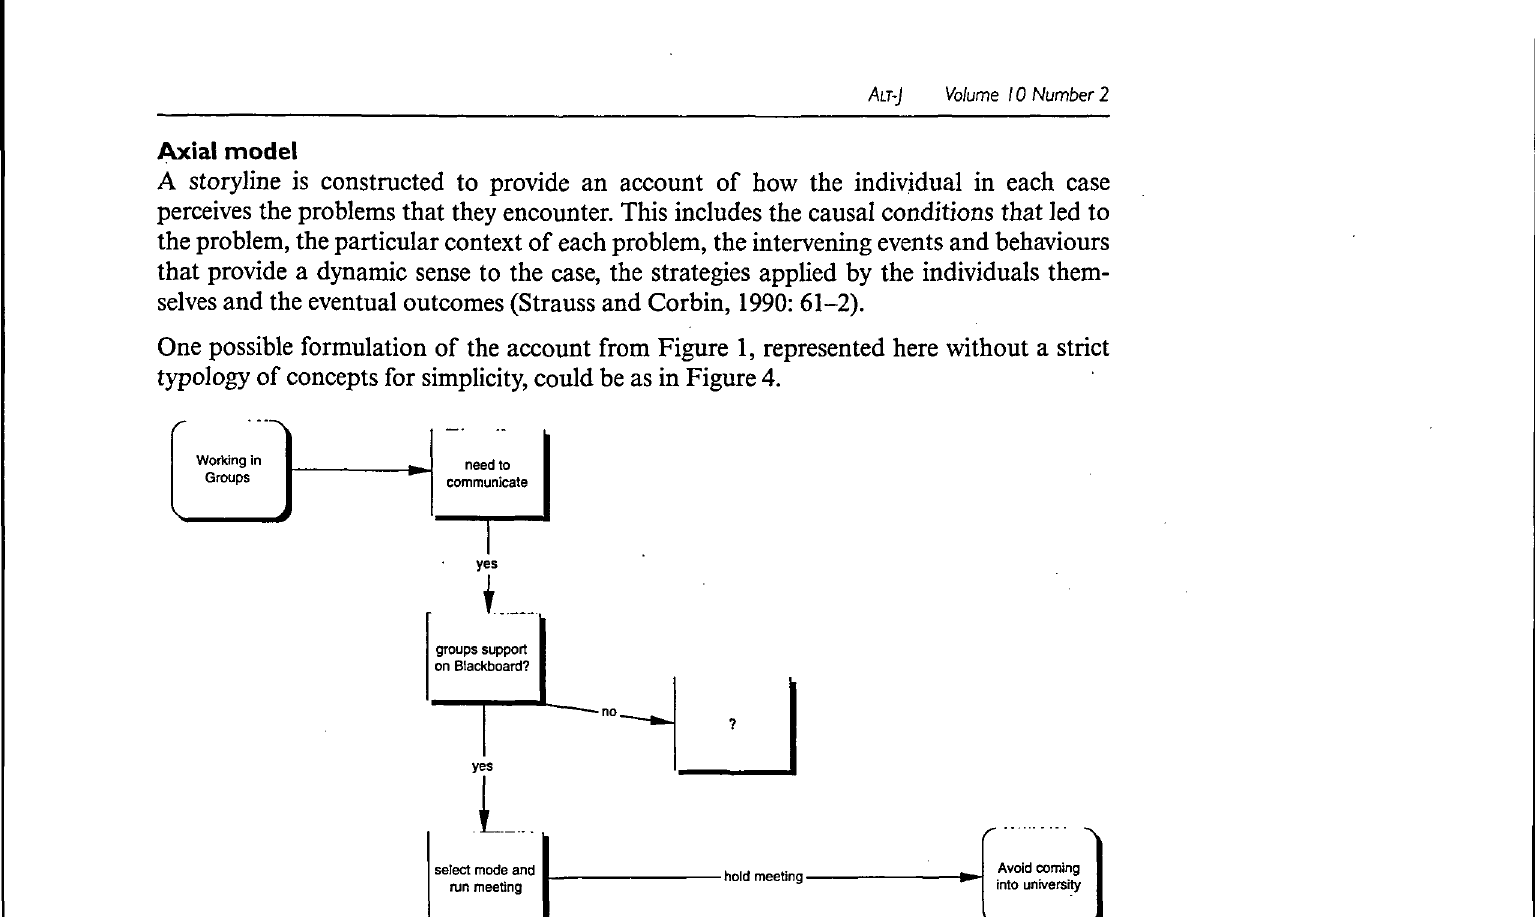
Figure 4: A formulation of the account in Figure